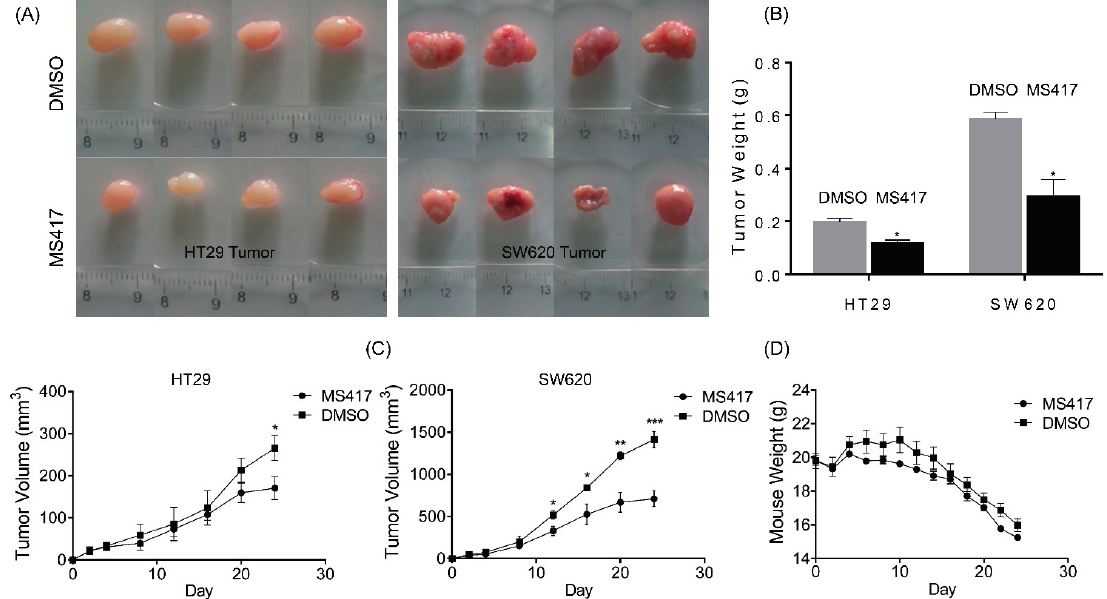
Figure 4. BRD4 inhibition impairs CRC tumor growth in vivo . ( A ) Macroscopic images of resected tumors at the conclusion of the experiment; ( B ) average weight of resected tumors; ( C ) average tumor volume of mice injected with either vehicle (DMSO) or MS417 (20 mg/kg, n = 4/treatment); ( D ) average mice weights with every 2-day injection of vehicle/MS417 over a time course of 3 weeks. * , p < 0.05; ** , p < 0.05; *** , p < 0.001. Values are depicted as Mean ±